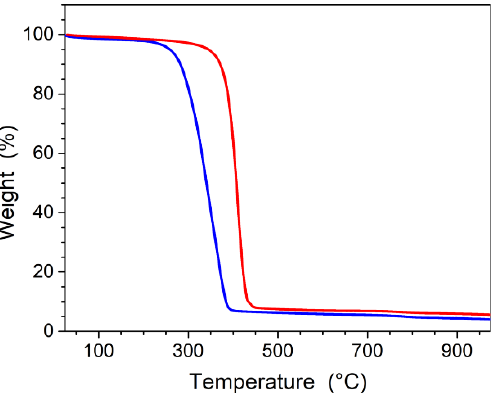
Figure A5. TGA of PS/γ -Fe 2 O 3 (red) and PMMA/γ -Fe 2 O 3 (blue). For a better accuracy, TGA experi- ments were combined to calcination of 20 – 25 mg sample amounts at 500 °C for one or several hours. Residual weight was constant after 1 h, giving an accurate iron oxide weight fraction confirming TGA results: 10.8 wt % (PS/γ -Fe 2 O 3 ) and 9.5 wt % (PMMA/γ -Fe 2 O 3 ).